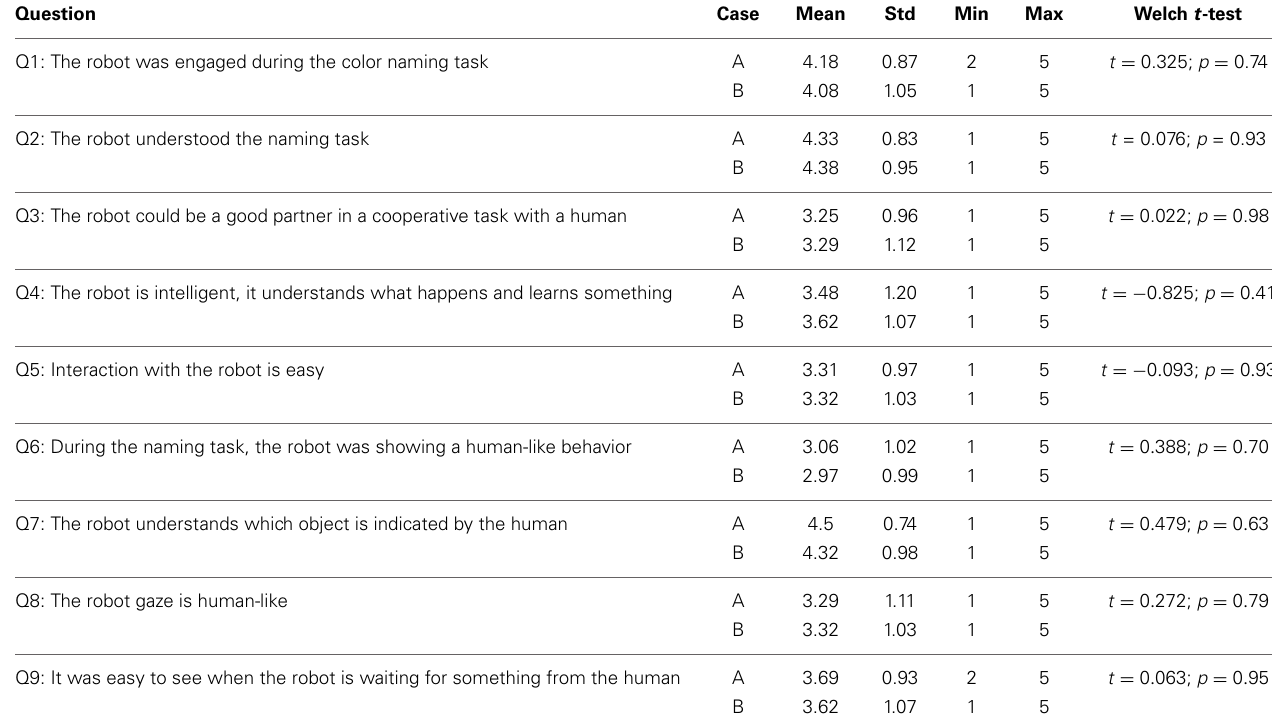
Table 5 | Post-experiment questionnaire for external observers. Question Case Mean Std Min Max Welch t